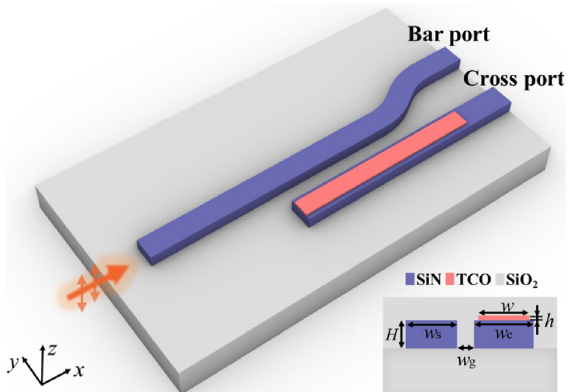
Figure 1. Perspective and cross-sectional view of the designed all-optical switch system. The proposed design includes an input waveguide and an ENZ TCO-loaded waveguide. The bar port and the cross port are outputs of the input waveguide and the TCO-loaded waveguide,